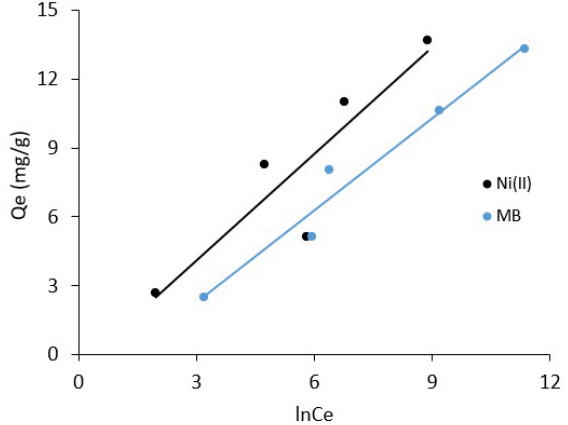
Fig.10. Temkin adsorption isotherm for removal of Ni(II) ions and MB onto natural clay